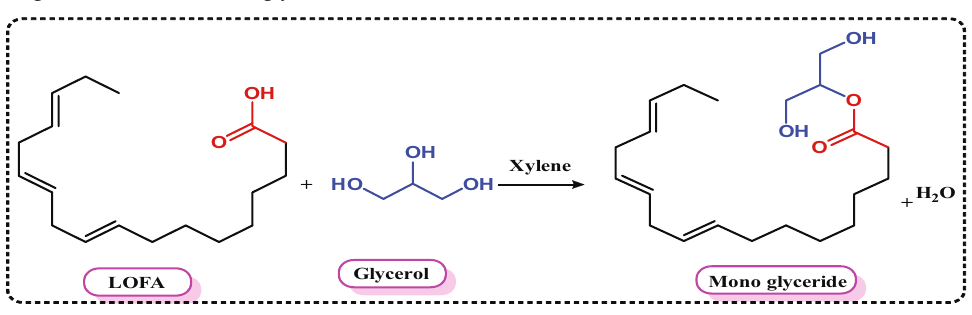
Stage 1: Formation of